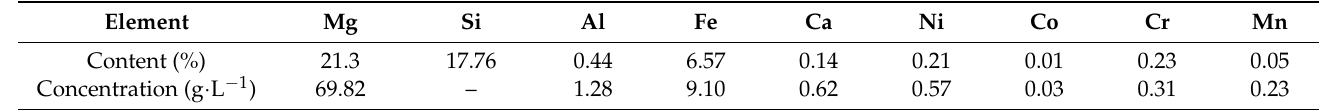
Table 1. The main component of serpentine and